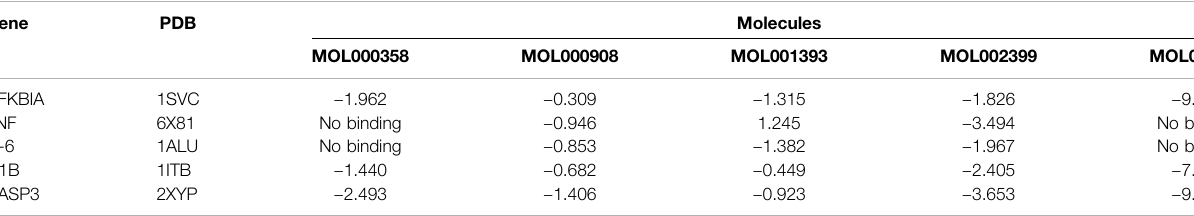
TABLE 8 | Molecular docking score (kcal/mol).